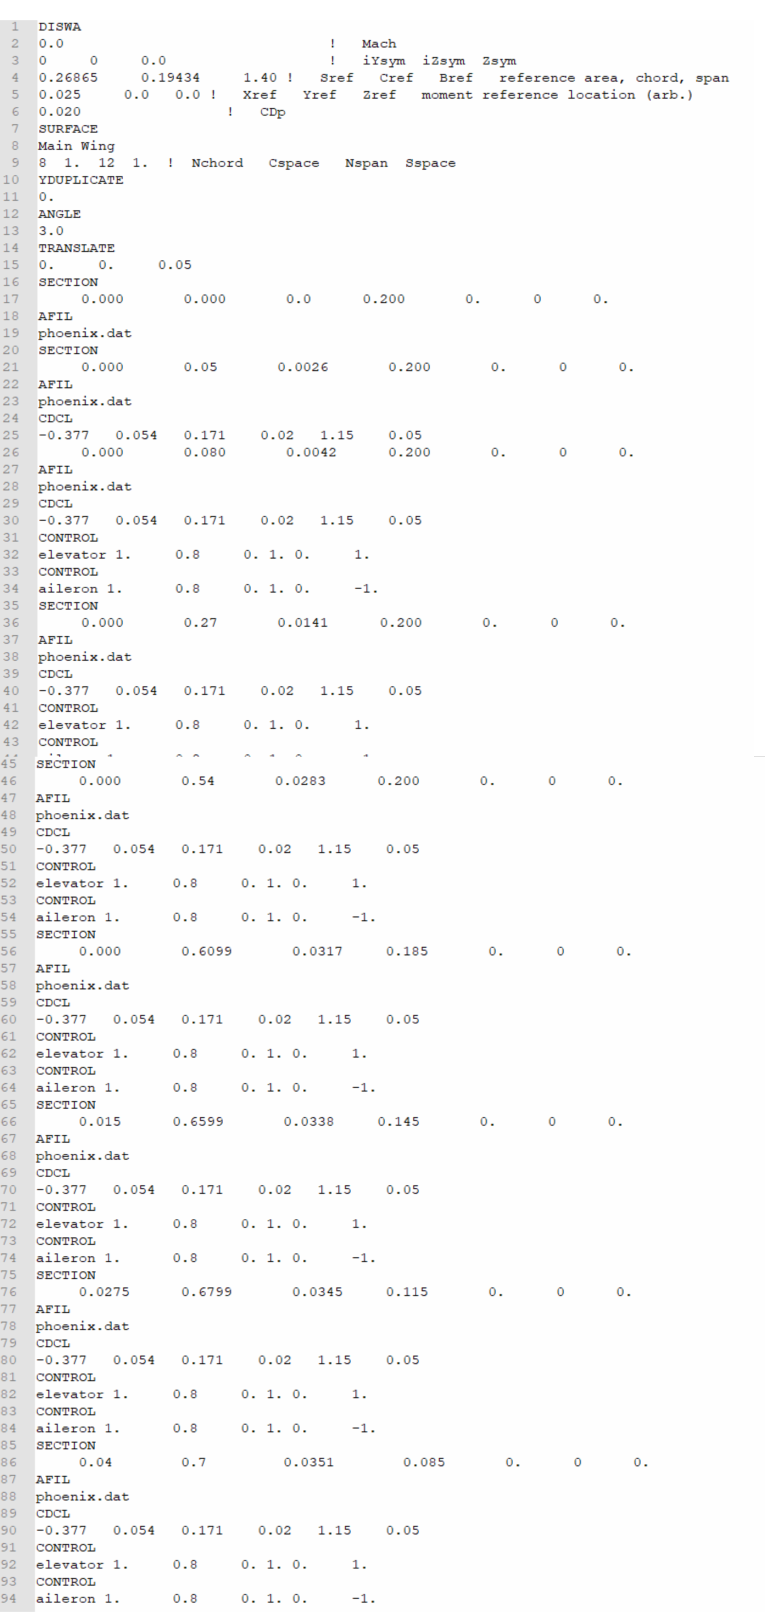
Figure A1. DISWA AVL input geometry